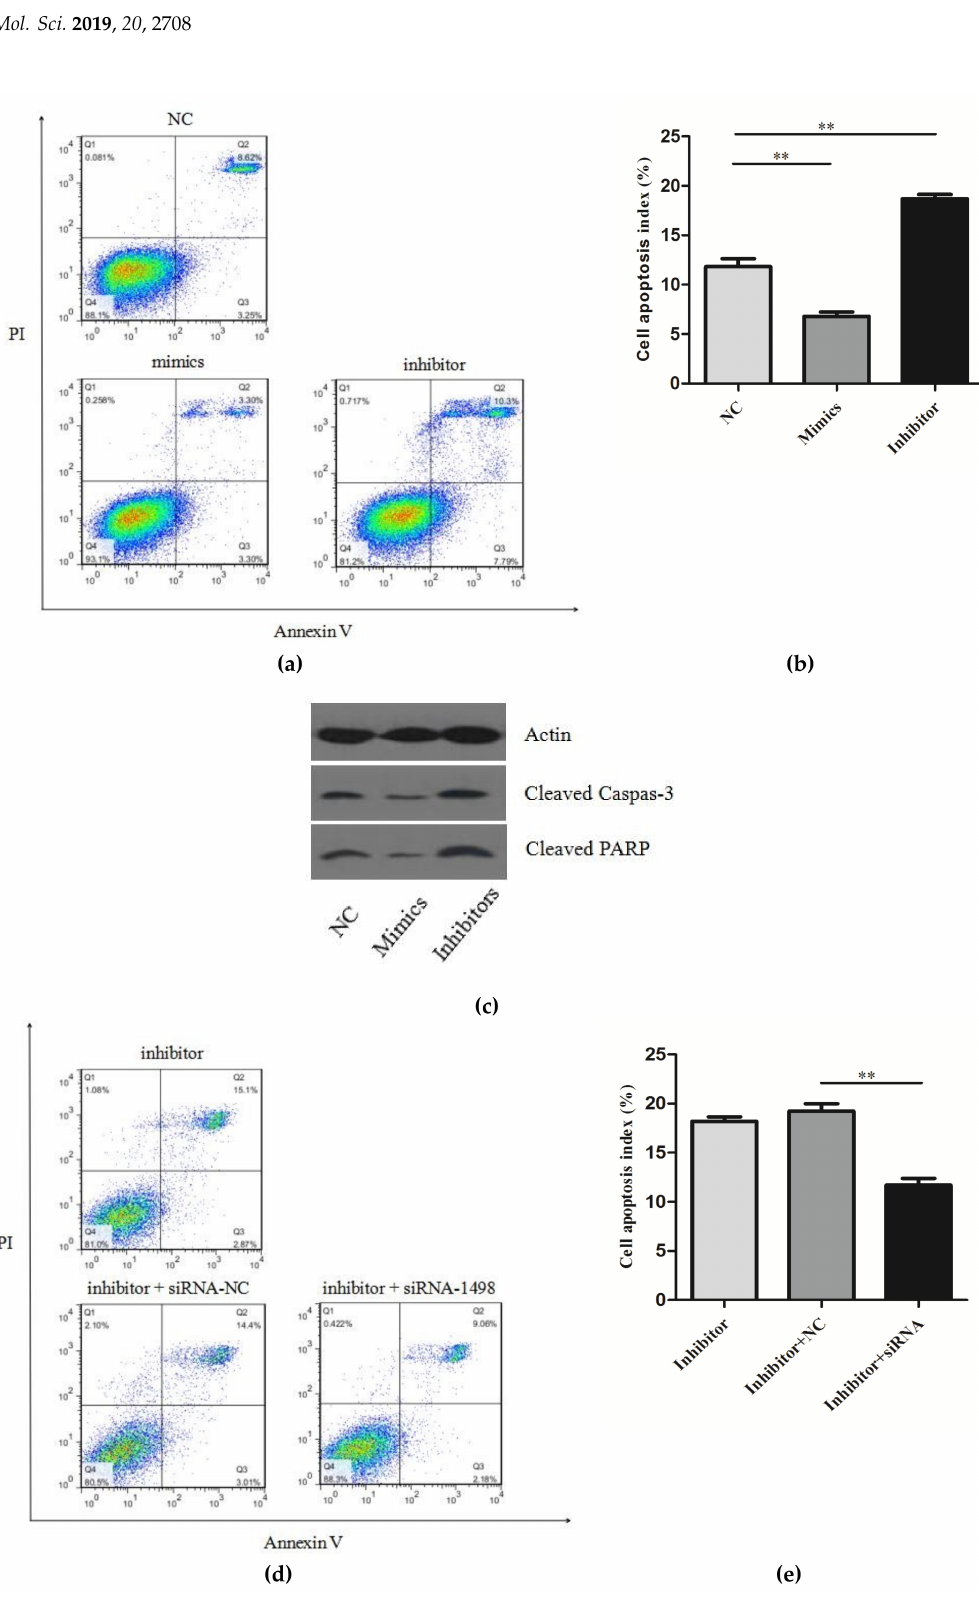
Figure 4. ( a ) Detection of the cell apoptosis of RAW264.7 transfected with NC, miR-150 mimics or miR-150 inhibitors; ( b ) Analysis results of the cell apoptosis index of the 3 groups in Figure 4a; ( c ) The expression of cleaved caspase-3 and cleaved PARP was detected by western blotting; ( d ) Detection of the cell apoptosis of RAW264.7 transfected with miR-150 inhibitors or RAW264.7 co-transfected with miR-150 inhibitors and siRNA; ( e ) Analysis results of the cell apoptosis index of the 3 groups in Figure